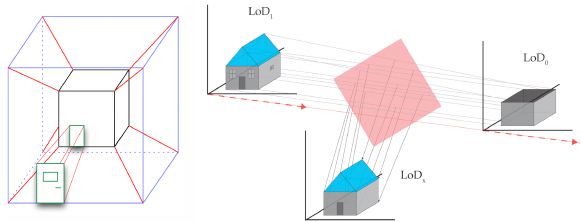
Figure 3. Conceptual view of slicing a new intermediary LOD between a finer and coarser level in 4D (van Oosterom and Meijers,